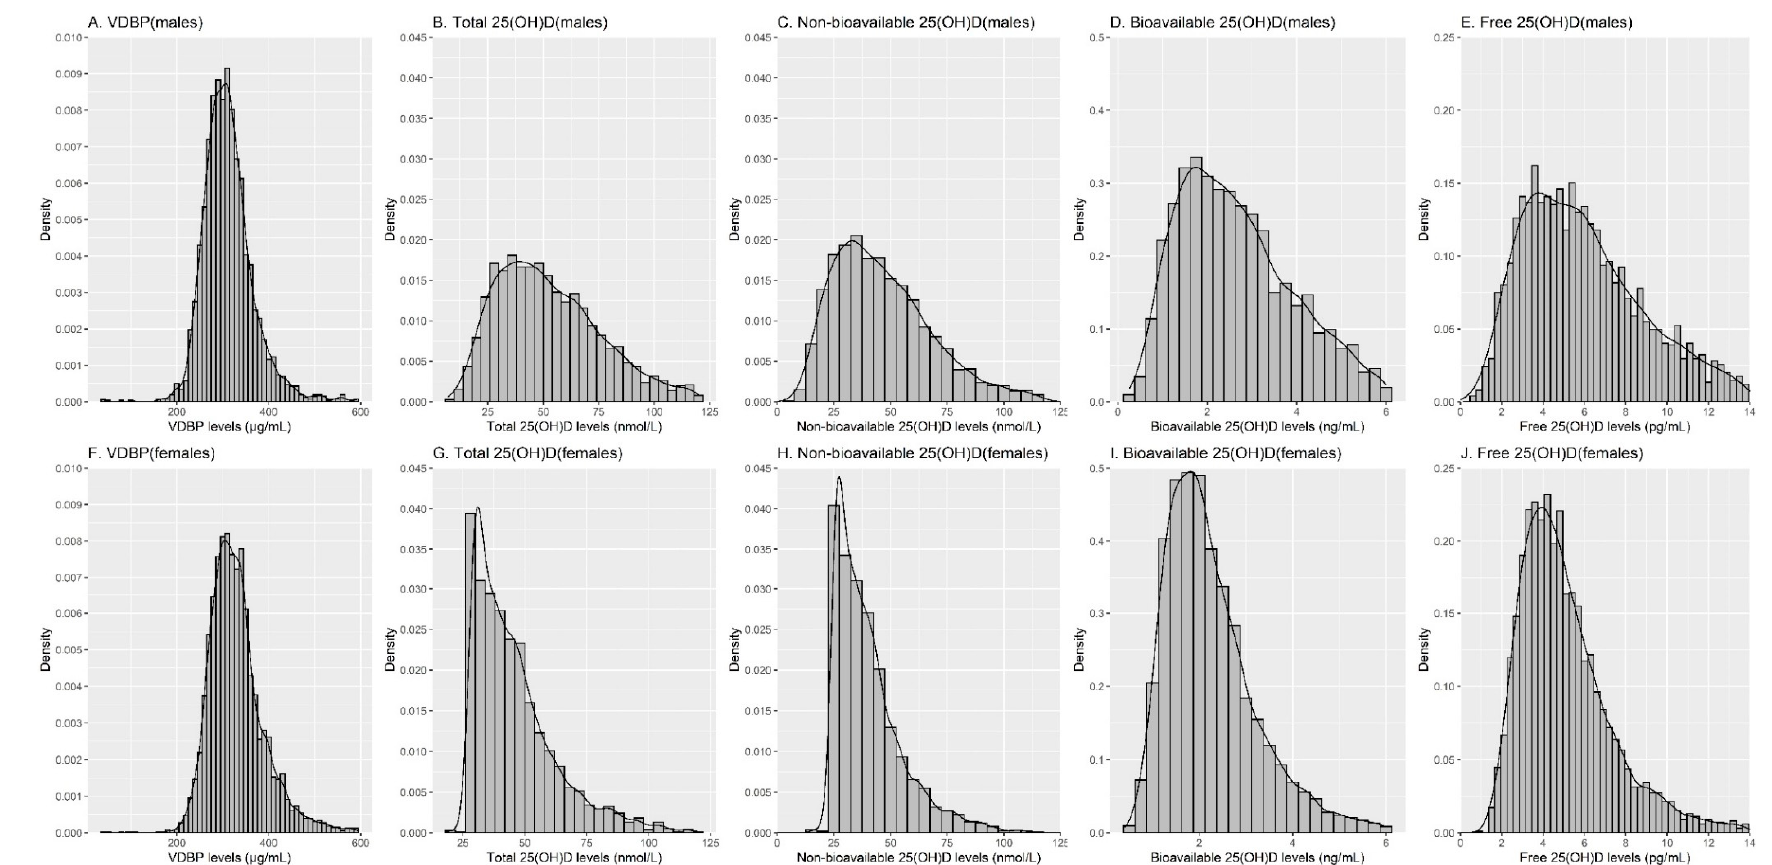
Figure 1. Histograms and density curves of VDBP, total, non-bioavailable, bioavailable, and free 25(OH)D concentrations by sex. Abbreviations: VDBP: vitamin D binding protein.